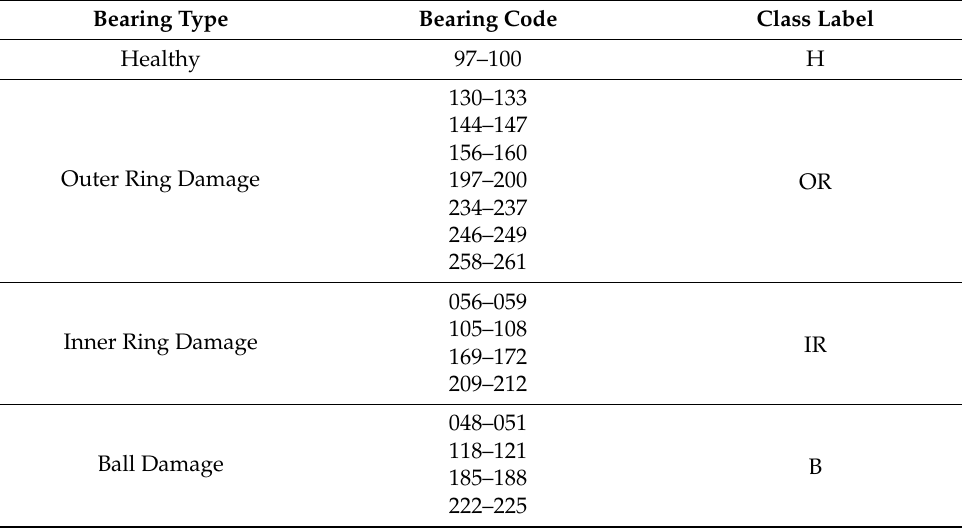
Figure 3. Case Western Reserve University testbed. Table 4. Arrangement of the CWRU dataset.